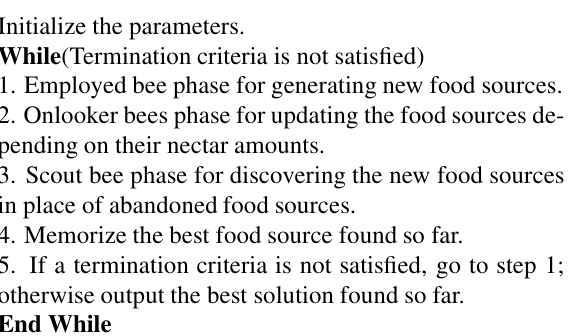
Artificial Bee Colony